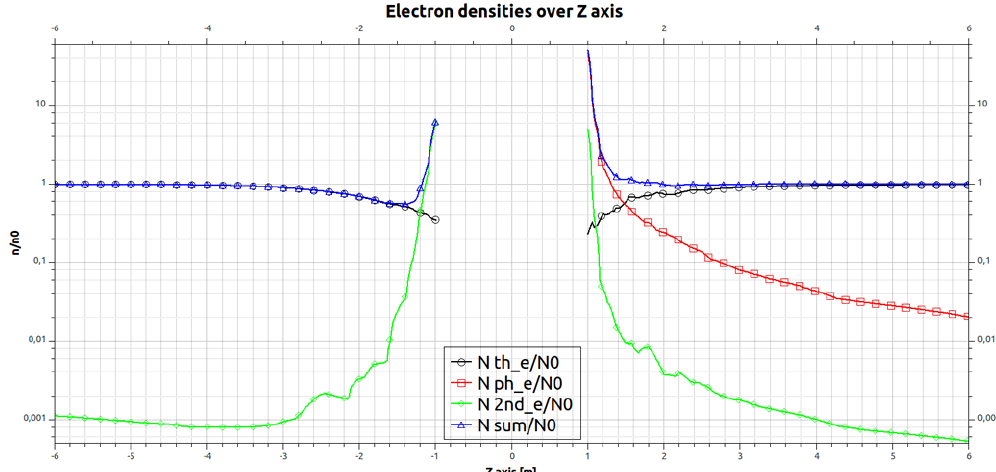
Fig. 14. Simulation S1: plot along the z-axis of electrons over n 0 , the plasma density: 7 × 10 9 m − 3 .